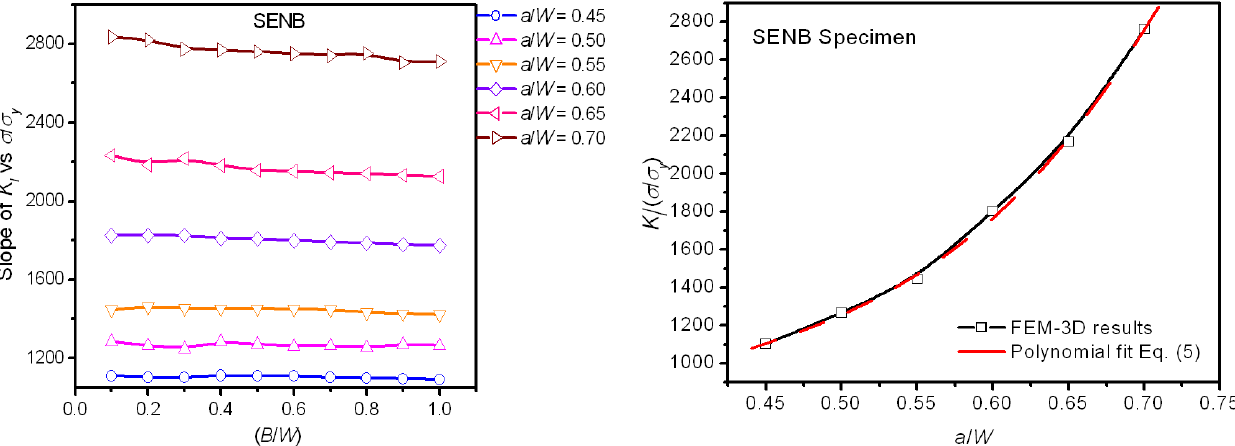
Figure 10: Variation of K